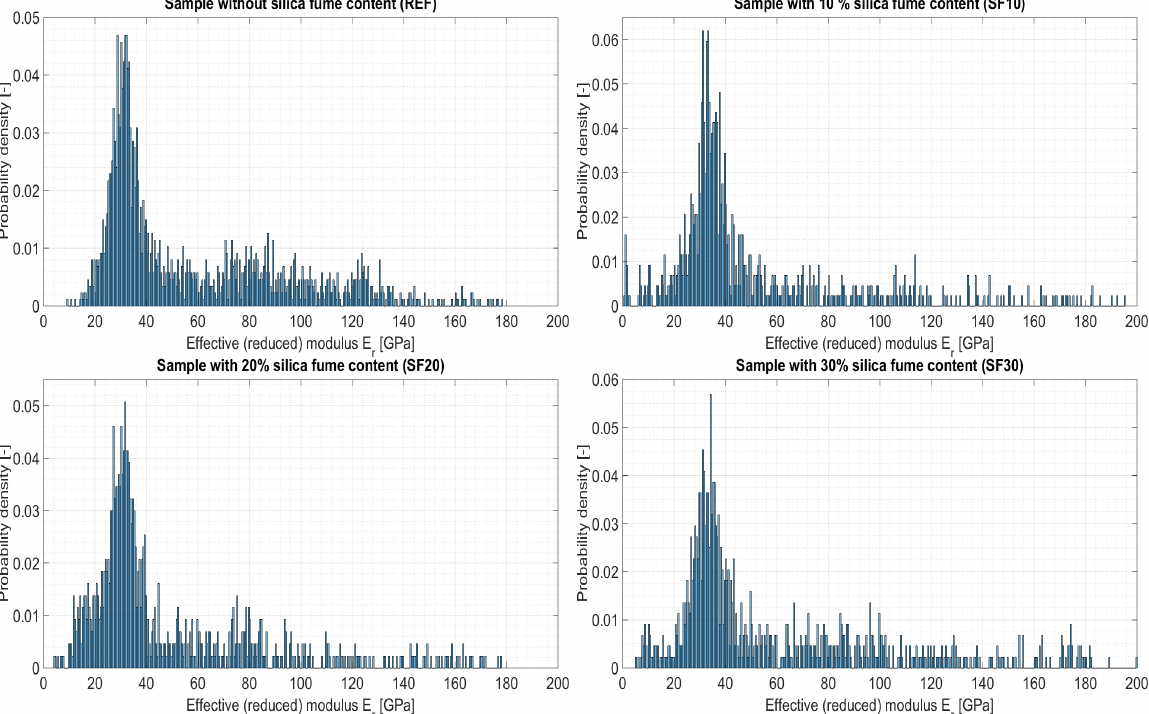
Figure 1. Histograms of indentation modulus E